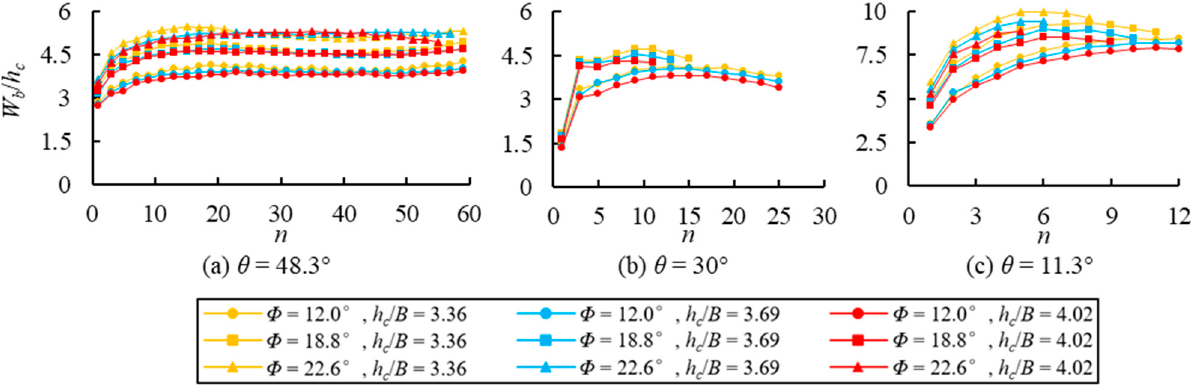
Figure 9. Dimensionless disturbed region width of W b / h c for bottom rotations: ( a ) θ = 48.3°; ( b ) θ = 30°; ( c ) θ = 11.3°.